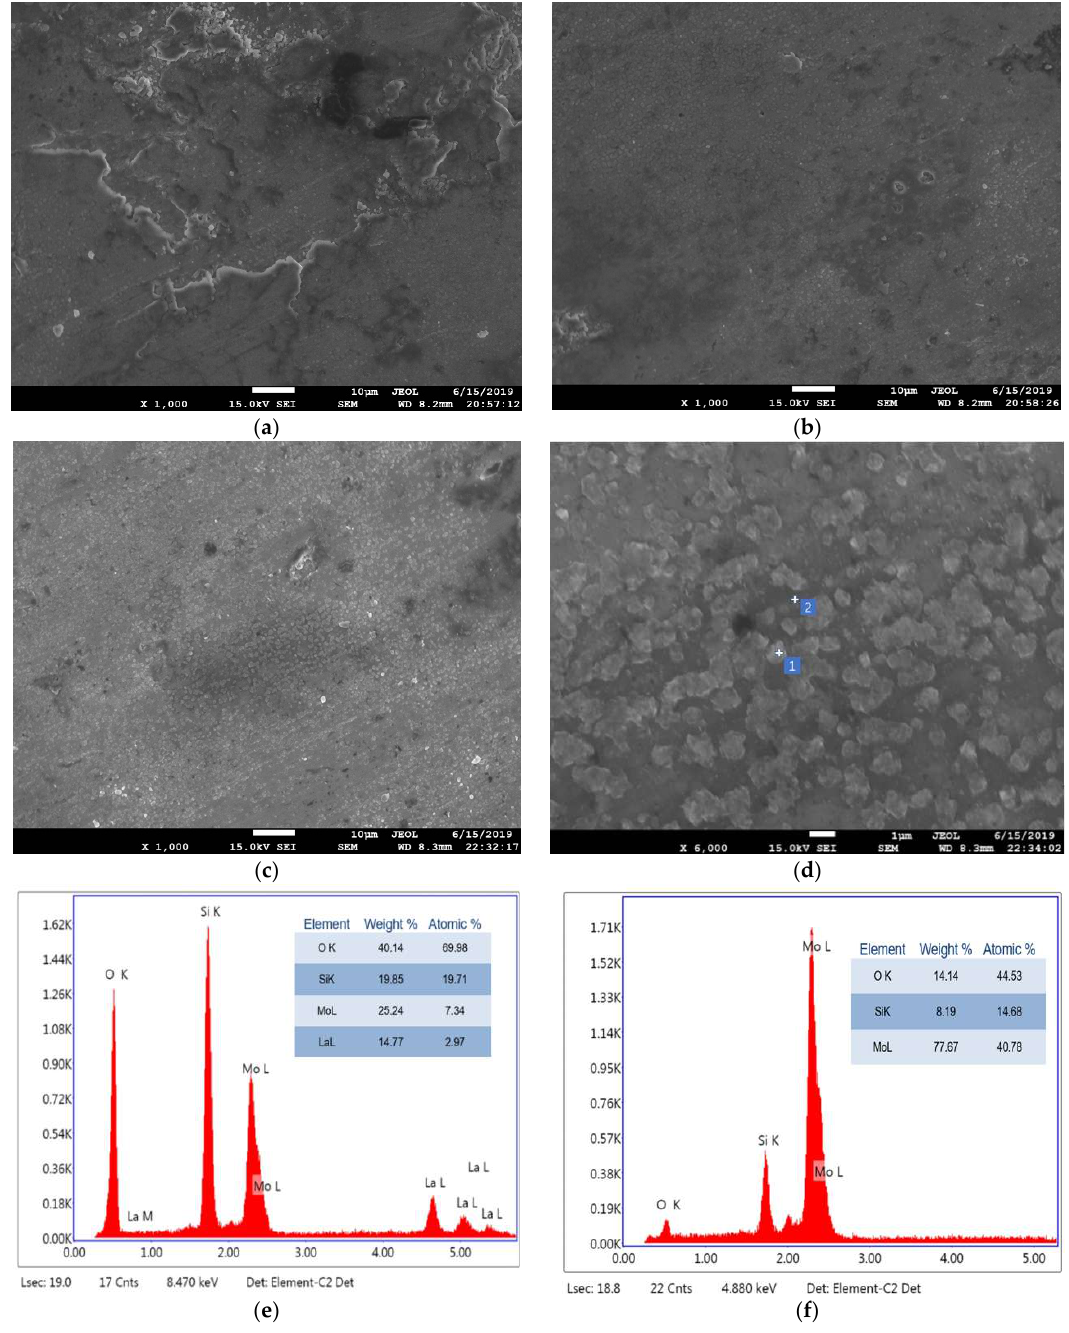
Figure 7. Representative SEM micrographs of 10Si-7B alloy after friction test: ( a ) at 973 K, ( b ) at 1073 K, ( c ) and ( d ) at 1173 K. ( e , f ) the EDS spectrums of P1and P2 in ( d ), respectively.